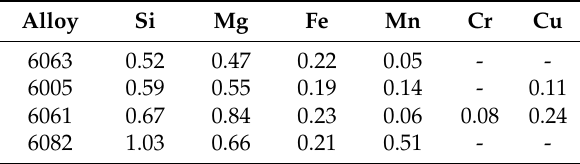
Table 1. Alloys investigated in this study. The compositions are shown in wt %, and are averages of four X-ray diffractometry scans of each billet.